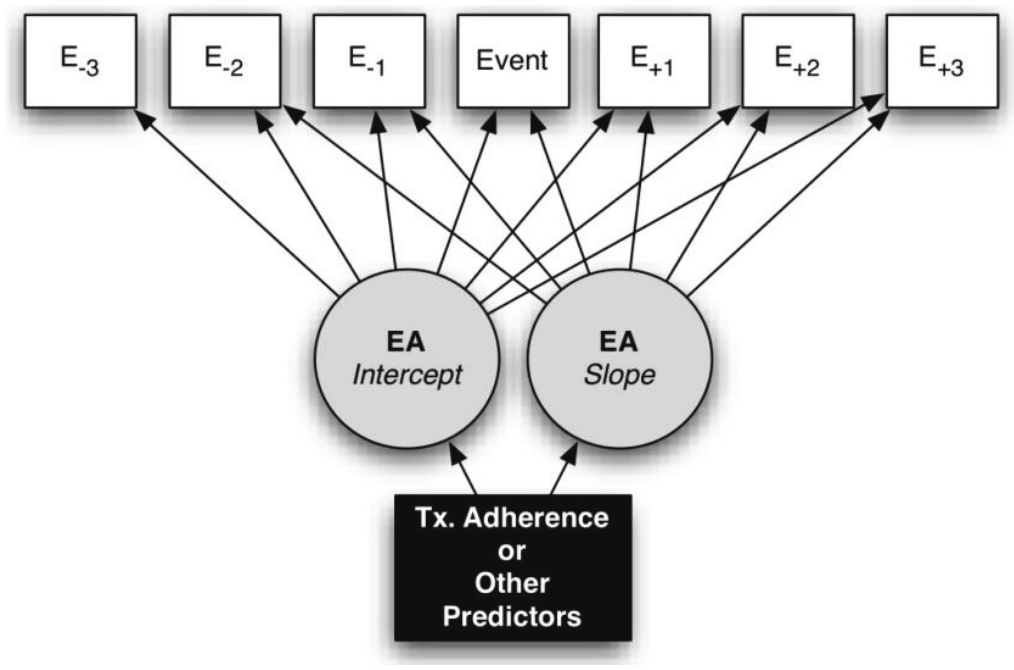
Figure 1. Model for one ecological assessment (EA) variable (e.g., psychotic symptoms) as a dynamic predictor of treatment adherence. “E” reflects nonadherence event, with + and − denoting assessments before or after